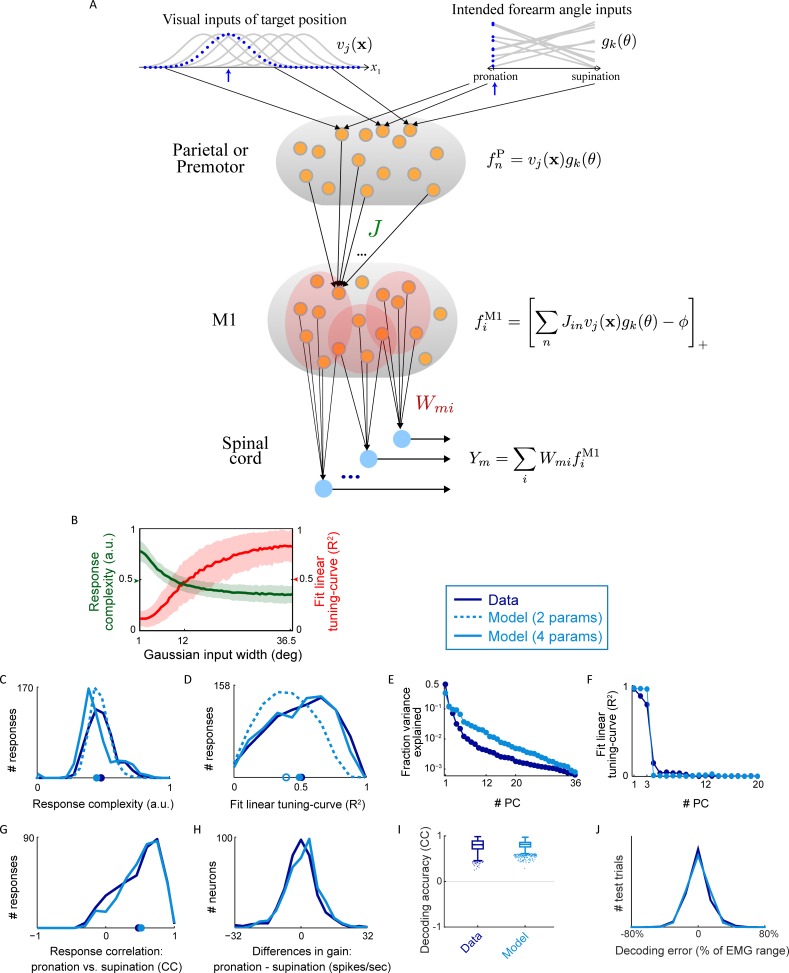
A. Feedforward neural network model for arm posture control. Visual inputs conveying target position are represented by array of 3D Gaussian units (here illustrated in 1D). For given target position (blue arrow) population response is a Gaussian bump (blue dots). Inputs representing intended forearm rotation angle are carried by second population of input neurons, each having a random preference for either pronation or supination, the population of responses for a pronation condition is shown in blue. The shape of their tuning curves for intermediate angles were not sampled in our task; they are drawn as lines only for illustration. Presynaptic parietal or premotor responses are modeled as a multiplicative interaction of the two input streams from a subset of “nearby” inputs from each (to maintain tuning). Each M1 response function receives a random set of 10,000 presynaptic inputs, but only a small fraction of these are active at any target. These are mixed through random connectivity J and passed through a threshold-linear nonlinearity. The EMG for each muscle is obtained from a linear combination of a subpopulation of such M1 neurons. These synaptic weights are the only ones in the model that require adjustment. B. Mean ± S.D. of response function complexity (left vertical axis) and R2 of fit to the spatial linear tuning-curve (right vertical axis) of model-generated responses (2-parameter model), as a function of the Gaussian width parameter for the visual inputs. This single parameter accounts for the higher spatial-linearity (wider Gaussian inputs) or higher spatial complexity (narrower Gaussian inputs) found in different response functions in the population. Arrows mark the mean values for the real data. C. Distribution of response function complexity for real data (blue, re-plotted from Fig 3D, mean = 0.49), and for the model-generated responses for the 2-parameter model (teal dashed line, mean = 0.49) and for 4-parameter model (solid line, mean = 0.46). Although only the mean of the data distribution was used for fitting, the model reproduces the entire shape of the data distribution well. D. Distributions of R2 values for fits to the linear tuning-curve for real data (mean = 0.5, S.D. = 0.22; re-plotted from Fig 3B), 2-parameter model (mean = 0.4, open circle, S.D. = 0.19), and 4-parameter model (mean = 0.49, S.D. = 0.23). E. Fraction of total variance explained of the PCA of the (54 conditions) real (adapted from Fig 3E) and model generated response functions. F. R2 values for fits of PCs to linear tuning-curve for the data- (Fig 3G) and the model-generated responses. G. Distribution of correlation coefficients between the pronation and supination responses for each neuron for the data (Fig 5B; mean = 0.48, S.D. = 0.31) and the model (mean = 0.51, S.D. = 0.28). This result involves no additional parameter fitting. H. Distributions of differences in gain for each neuron across forearm angles for the data (S.D. = 8.7 spikes/s) and the model (S.D. = 8.4 spikes/s). We scaled response of each model neuron for both forearm angles to match the range of firing rates of a randomly chosen real neuron without using any forearm angle information in this scaling. I. EMG decoding correlation coefficients using the real data (Fig 4B) and the model response functions. J. Same for the distributions of decoding errors (Fig 4C).